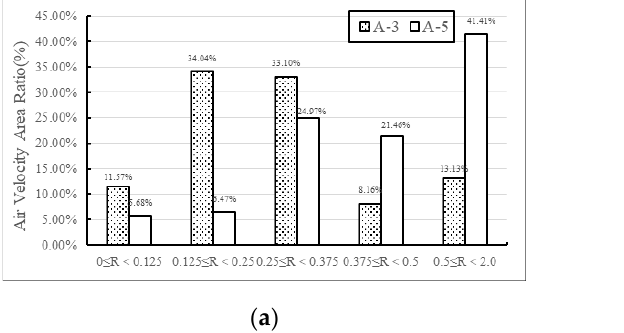
Figure 12. Column Analysis Chart: ( a ) air velocity area ratio of A-3 and A-5 kitchens. ( b ) PM2.5 concentration area ratio of A-3 and A-5 kitchens.